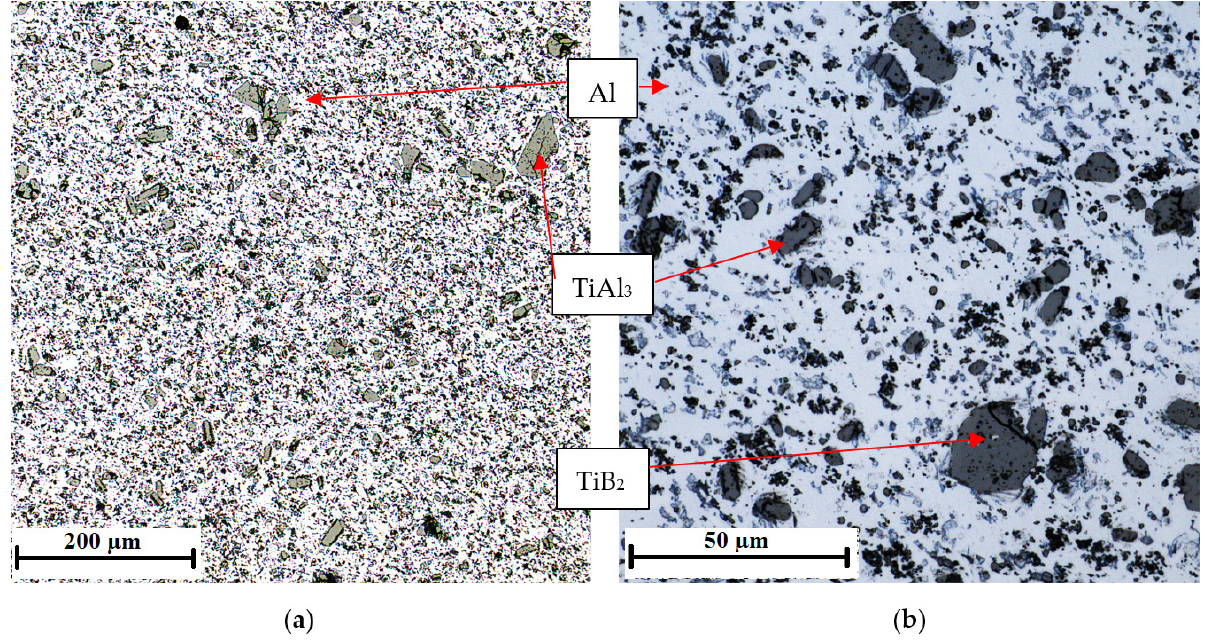
Figure 6. Histogram of the particle size distribution of the TiAl 3 phase in the AlTi3B1 alloy. The microstructure of the AlTi5B1 inoculation wire shows the aluminum matrix and large plate-shaped or coarse-edged or irregularly shaped intermetallic particles and fine flaky particles of irregular shape (Figure 7). Compared to the AlTi3B1 alloy, the AlTi5B1 alloy has a larger number of TiAl 3 intermetallic phases in the structure with different irregular shapes.